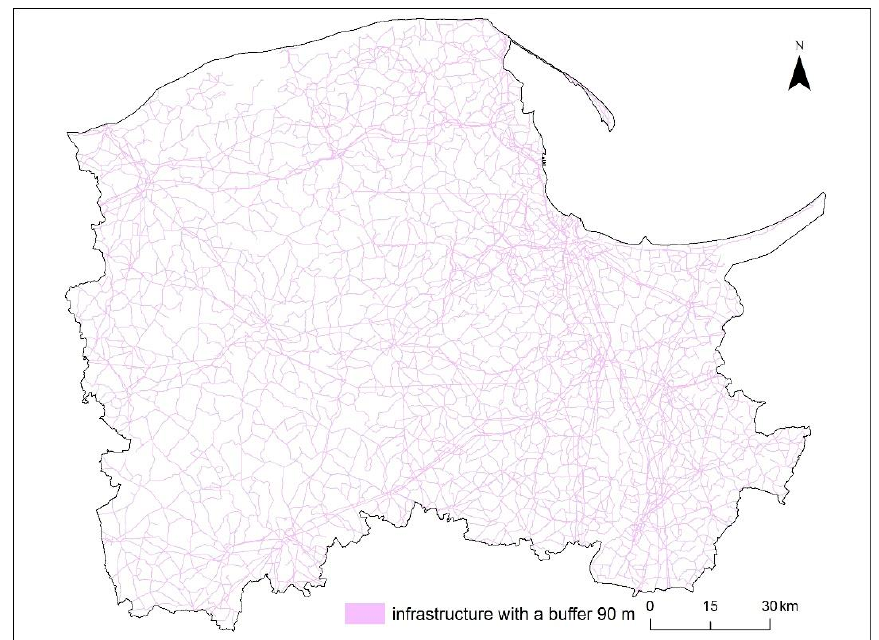
Figure 6. Infrastructure with a 90 m buffer (own elaboration).